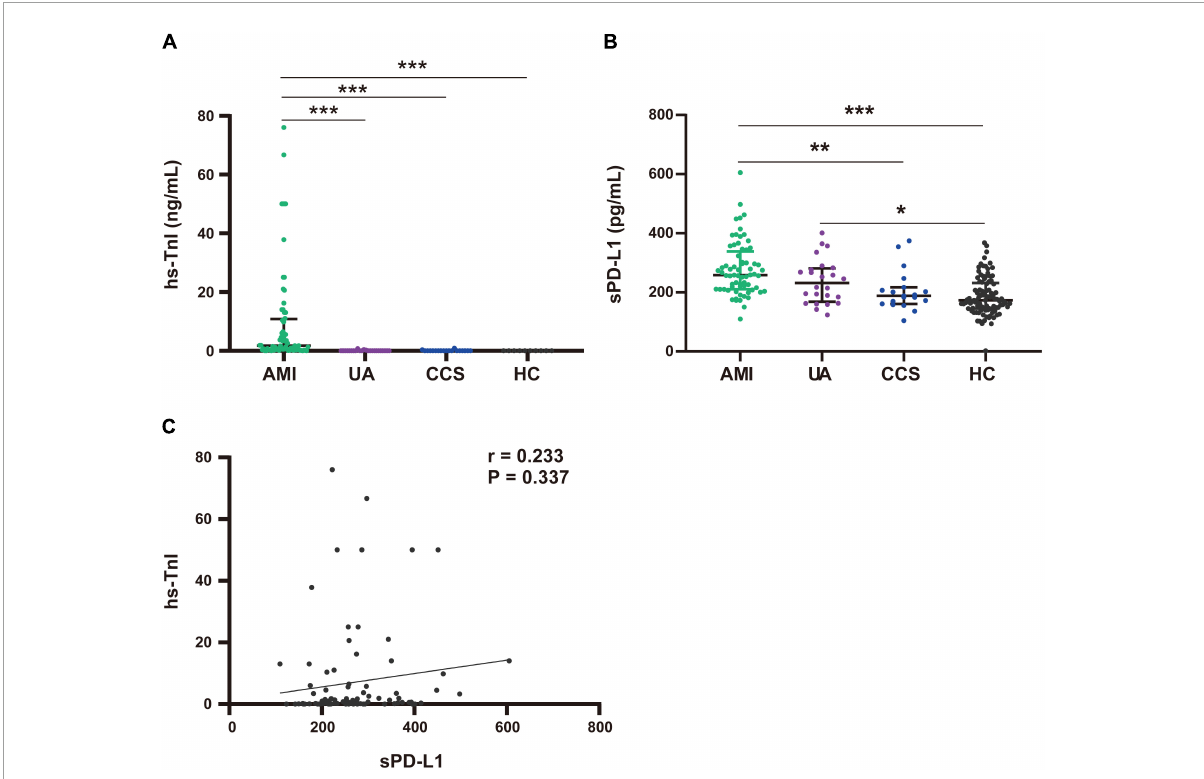
FIGURE3 Comparison of plasma hs-TnI and sPD-L1 levels among the AMI, UA, CCS and HC groups. (A) Comparison of hs-TnI levels among the AMI ( n = 68), UA ( n = 24), CCS ( n = 19), and HC ( n = 10) groups. (B) Comparison of sPD-L1 levels among the AMI ( n = 68), UA ( n = 24), CCS ( n = 19), and HC ( n = 97) groups. (C) Association analysis of sPD-L1 with hs-TnI in the ACS group ( n = 92). * p < 0.01, ** p < 0.01, *** p < 0.001. hs-TnI, high-sensitivity troponin I; sPD-L1, soluble programmed cell death ligand-1.